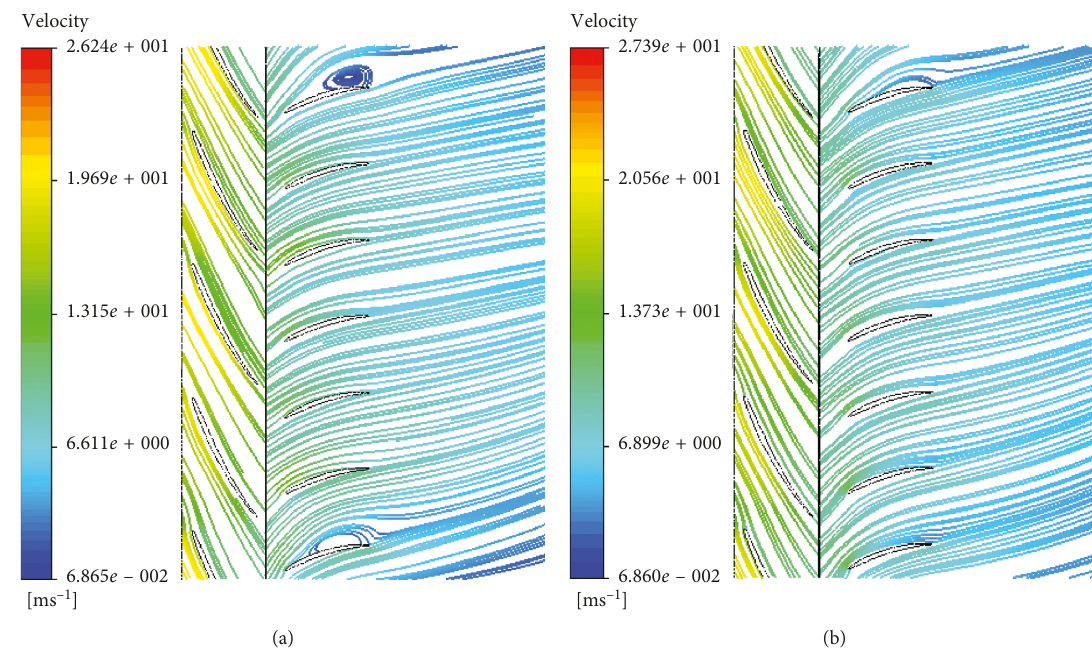
Figure 6: Distribution of streamline around the blade and guide vane at 0.5 times blade height. (a) Original model. (b) Optimized model.